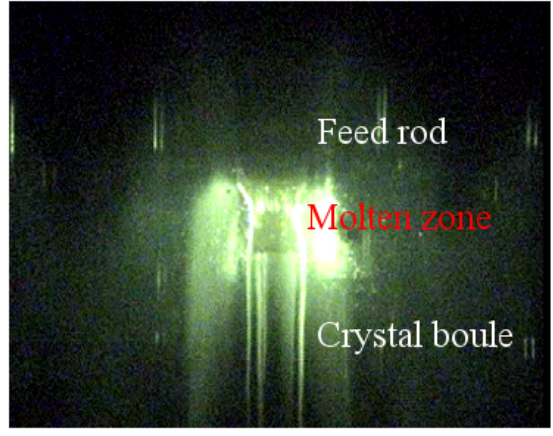
Figure 4. Floating zone growth of a boule of Pr 2 Zr 2 O 7 in air at a growth rate of 12.5